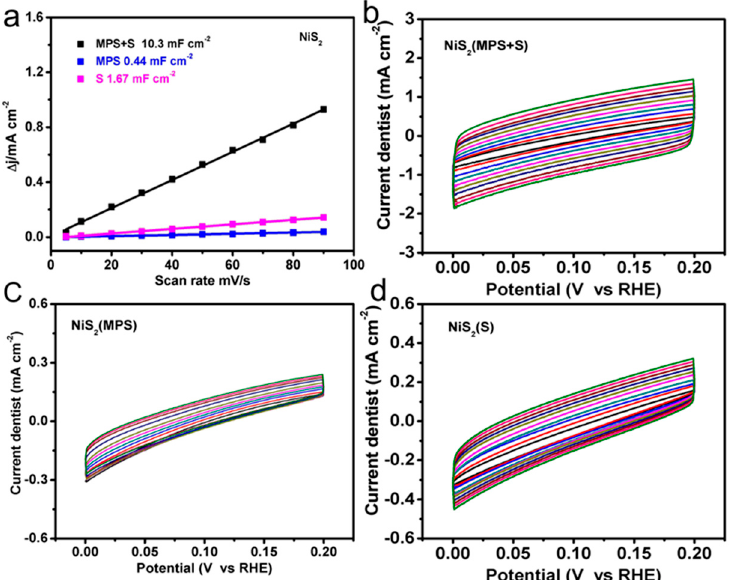
Figure 4. ( a ) The double-layer capacitance (C dl ) calculated by liner fitting of the capacitive currents of different catalysts versus scan rate. ( b – d ) Cyclic voltammograms of NiS 2 prepared by different experimental